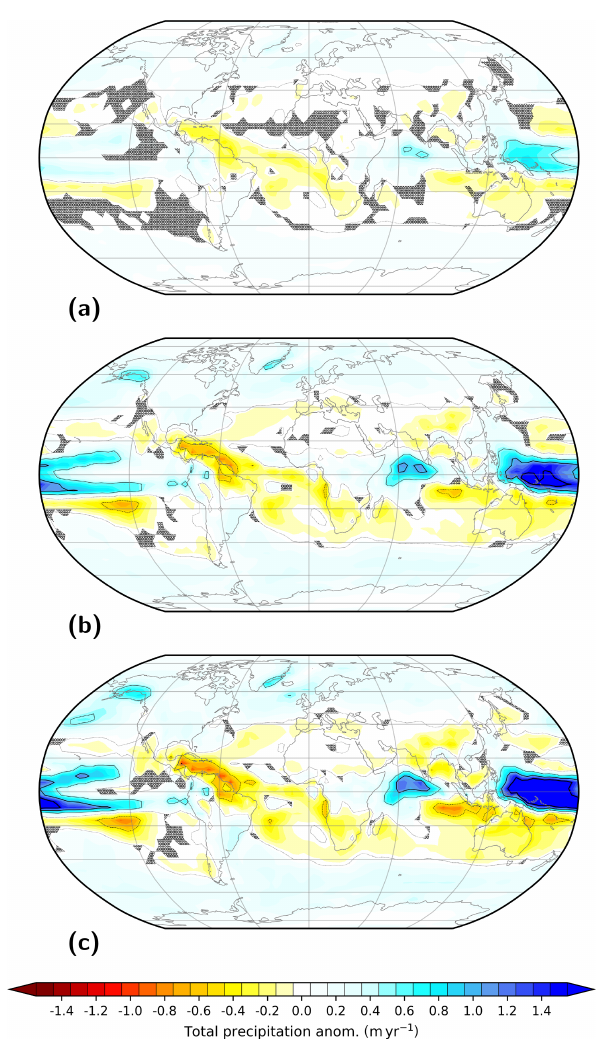
Figure 20. Sensitivity of annual mean total precipitation to varia- tions in the volume mixing ratio of carbon dioxide for modern ge- ography. Shown are anomalies with respect to pre-industrial (E280) for simulations (a) E400, (b) E560, and (c) E600. Contours illustrate isolines of − 1 . 0myr − 1 (dashed, thin), 0.0myr − 1 (dotted, thin), 0.5myr − 1 (solid, thin), 1.0myr − 1 (solid), and 1.5myr − 1 (solid, thick). In hatched regions the anomaly is insignificant at the 95% confidence interval based on a t test. Total precipitation integrates contributions from large-scale and convective precipitation in the liquid and solid phase.